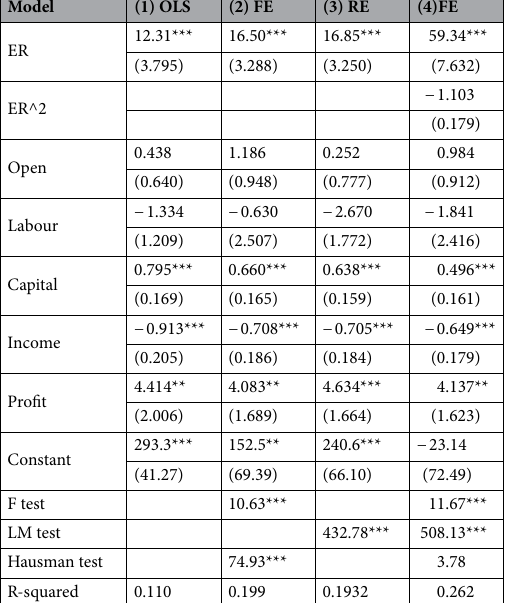
Table 3. Results of baseline regression of HTFP by ER. **, ***indicate significance at the 5% and 1% level, and the standard errors are